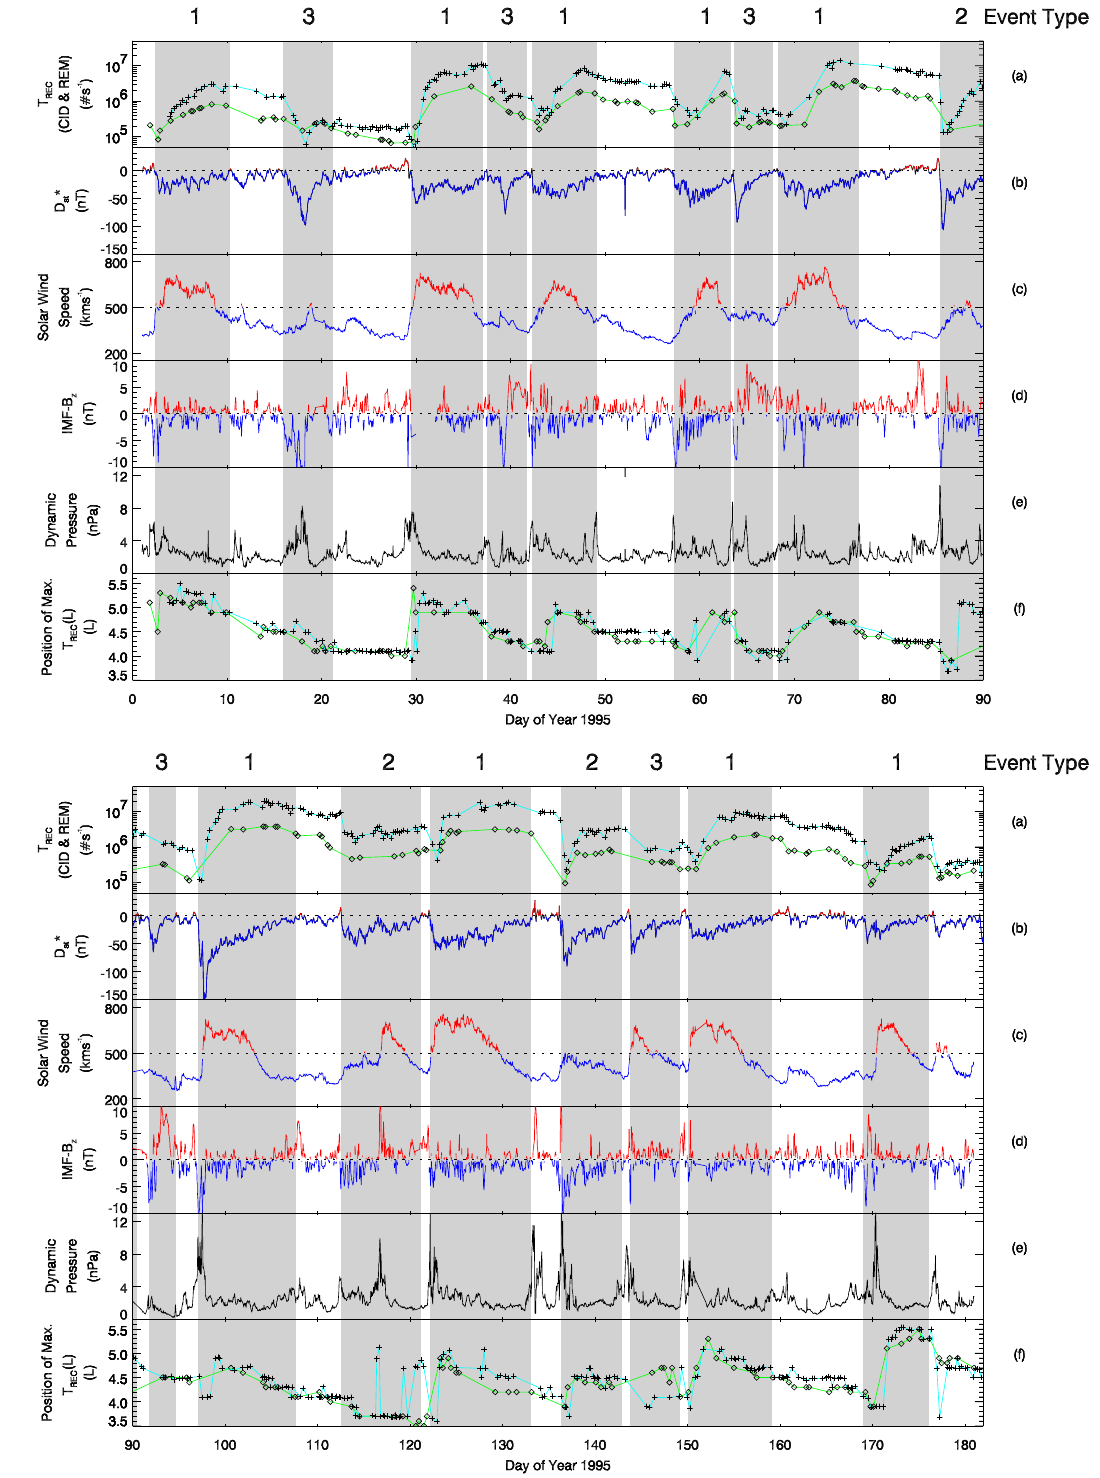
Fig. 1. The relativistic electron response during magnetic storms is compared with solar wind and geomagnetic parameters during the first six months of 1995. The panels show (a) a relative measure of the Total Relativistic Electron Content ( T REC ) in the range 3 . 5 < L < 6 . 5, REM (blue line), CID (green line); (b) D st *(nT); (c) the solar wind speed (km − 1 ) ; (d) IMF- B z (nT); (e) the solar wind dynamic pressure (nPa); (f) and the position of the maximum T REC (L) in the outer radiation belt (L) . The shaded areas define the magnetic storms studied with the event type indicated along the